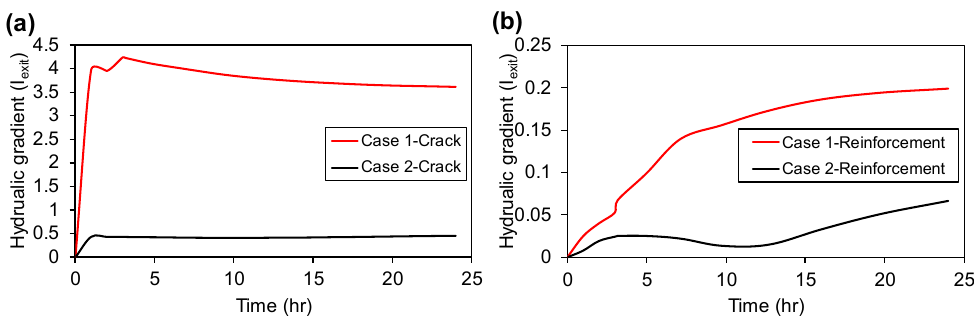
Figure 10. Time histories of variations in hydraulic gradients under ( a ) crack and ( b ) reinforcement conditions.